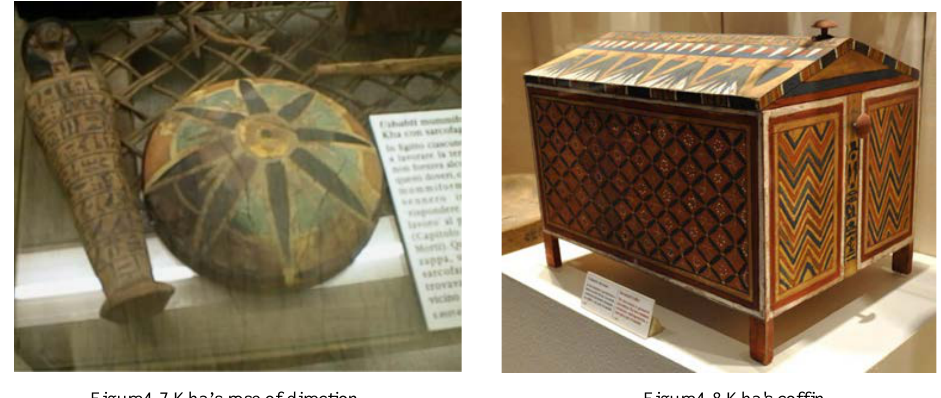
Figure4-7 Kha’s rose of direction Figure4-8 Kha's coffin